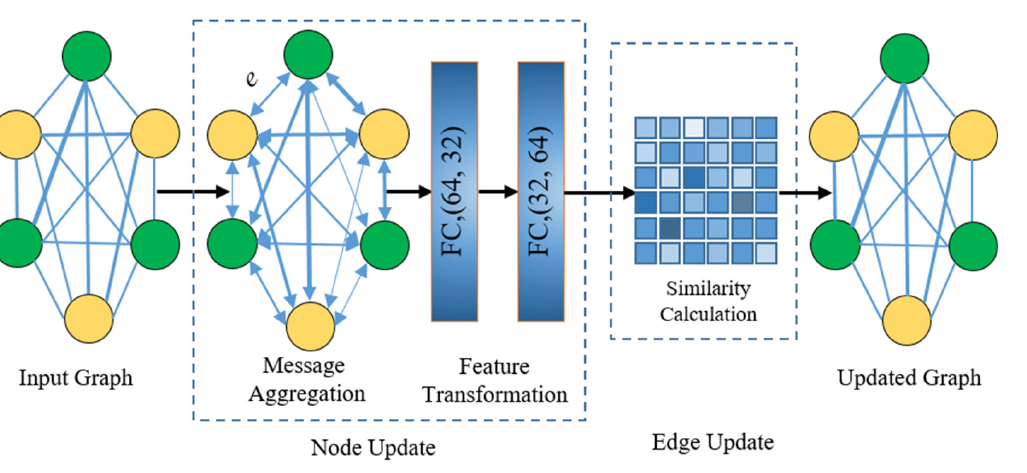
Figure 8. Structure of GUM used in GDAN.